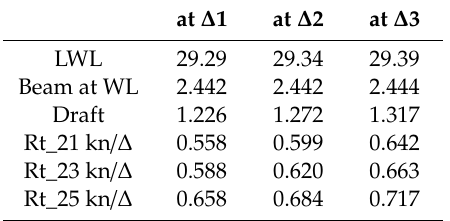
Figure 7. Calm water resistance per ton of displacement against nondimensional beam at WL at 25 kn for ( a ) ∆ 1 and ( b ) ∆ 3. Table 3. Obtained results for the selected design (battery racks in the